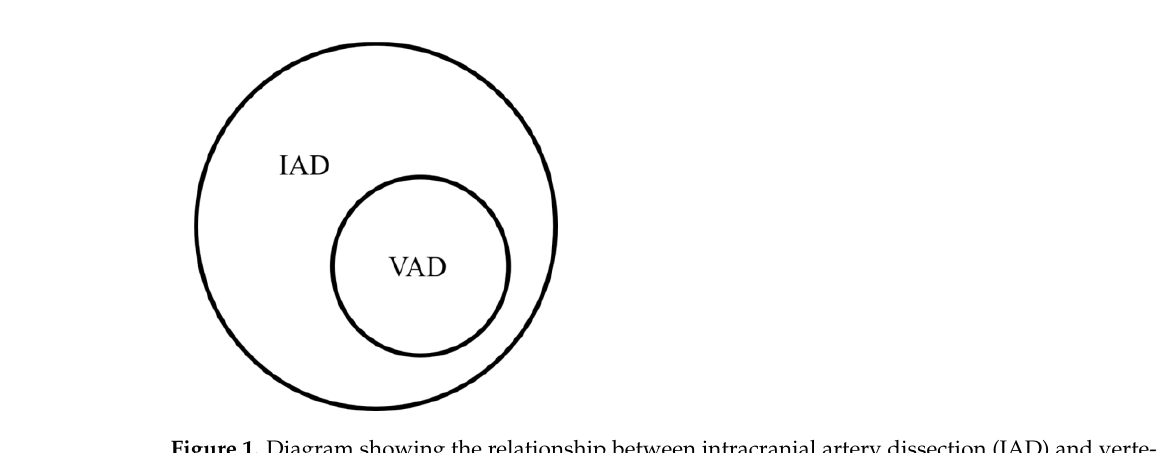
Figure 1. Diagram showing the relationship between intracranial artery dissection (IAD) and verte- bral artery dissection